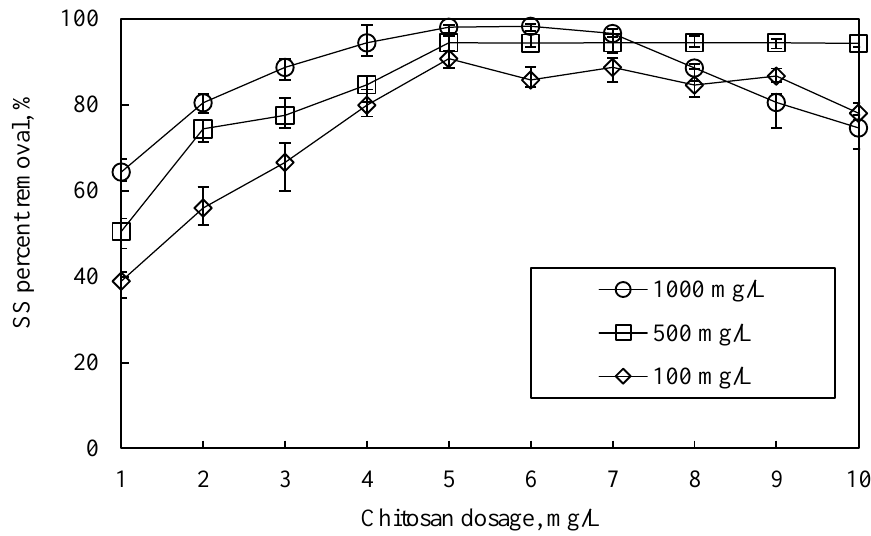
Figure 5. Variation in the percent removal of SS by different dosages of chitosan. The error bars represent range of the observed values.